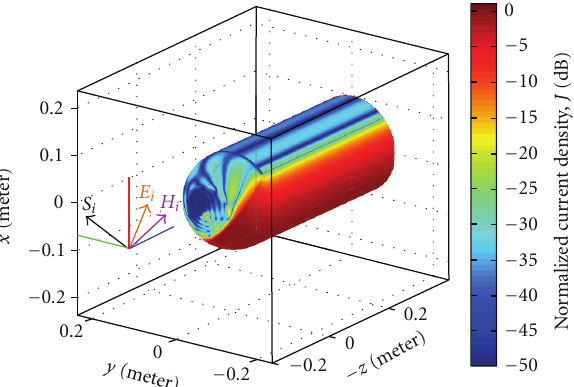
Figure 5: Surface current density using PO method for an incident field θ = 60 ◦ , φ = 45 ◦ .